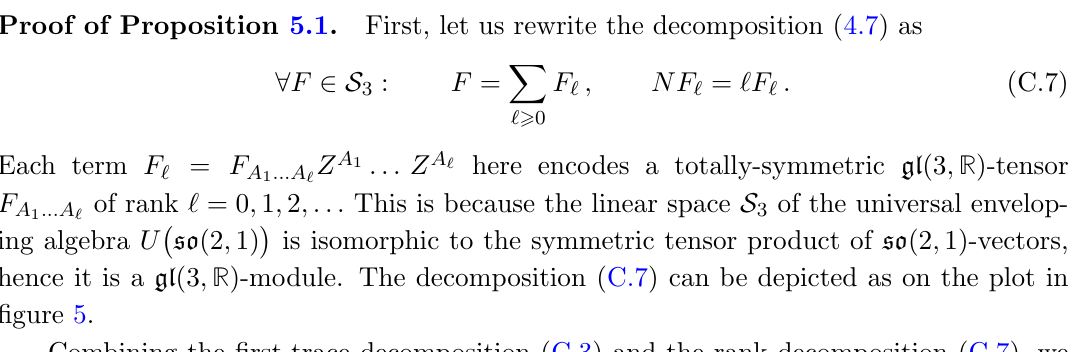
Figure 5 . The gl (3 ; R )-covariant basis in the universal enveloping algebra U